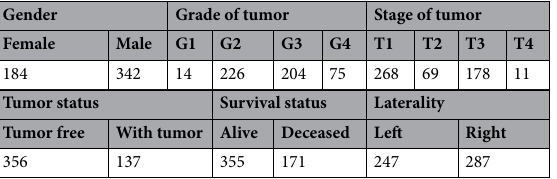
Table 1. Patients’ characteristics. Sub-tables indicate the number of patients in each category. Differences in the numbers are due to missing information for some